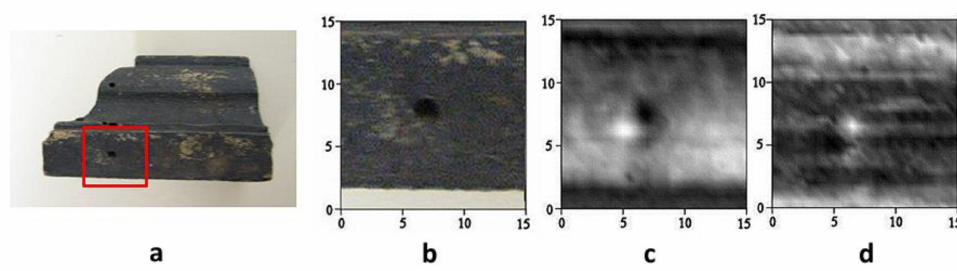
Figure 10. THz image of an ancient wood fragment: ( a ) fragment with identification of the scanned area; ( b ) visible image; ( c , d ) THz images taken at di ff erent distances.